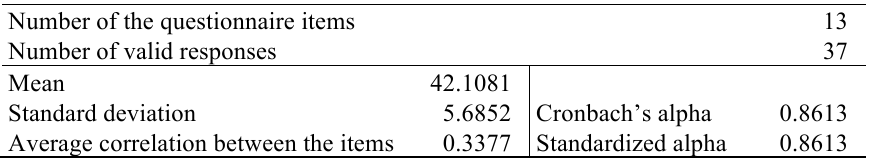
Table 1. Overall questionnaire statistics